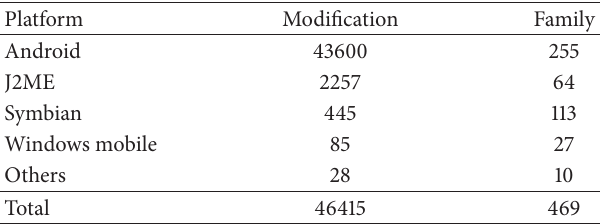
Table 2: Modification of threats among Smartphone OS-IDC worldwide quarterly mobile phone tracker, May